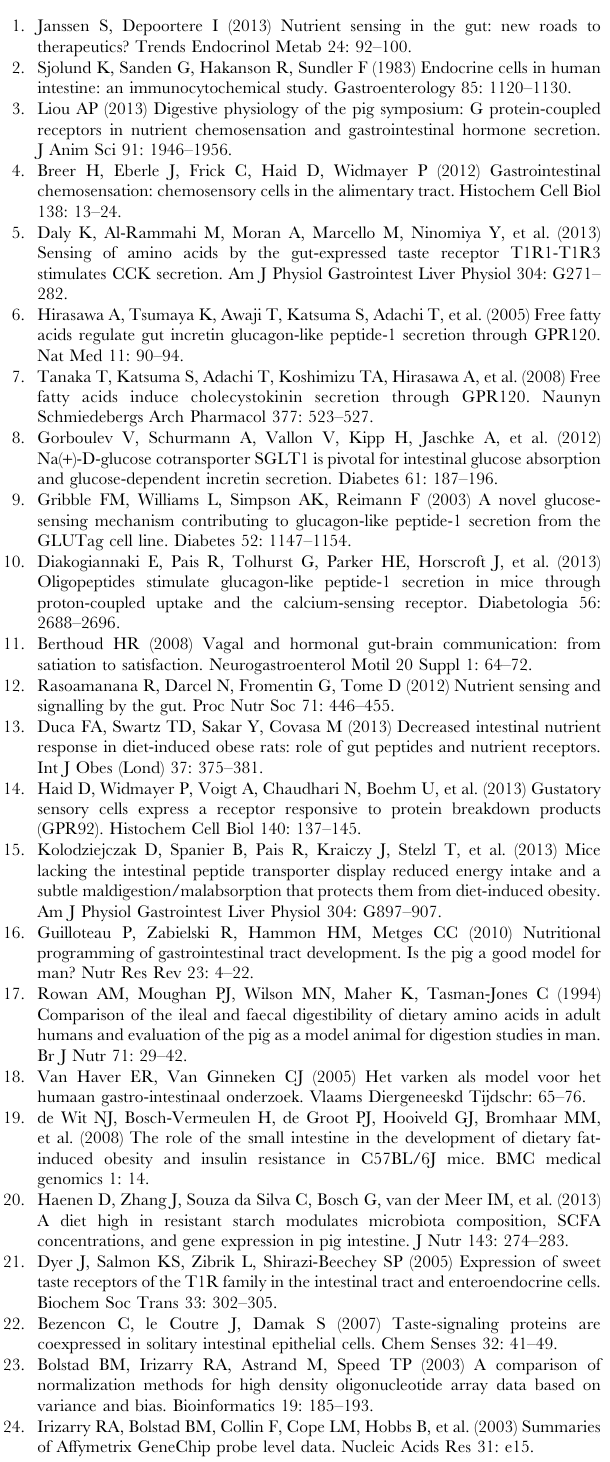
Table S2 Human primers used for qPCR